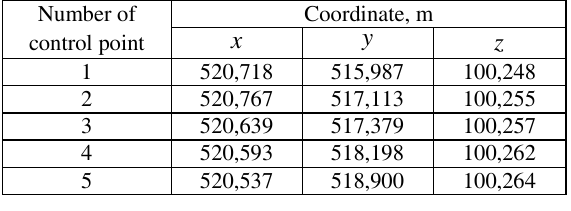
Table 2. Coordinates of control points in the object